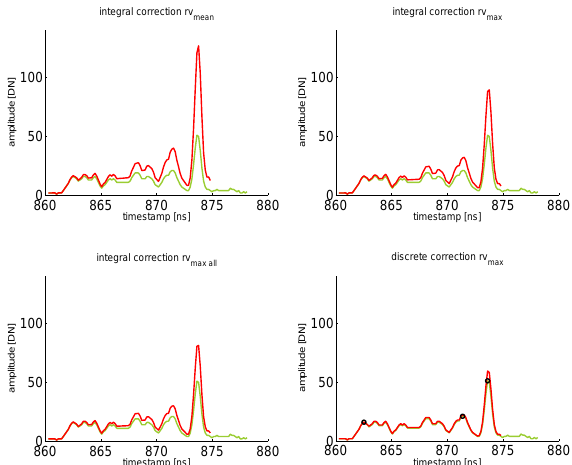
Figure 8: Comparison of raw data and corrected data with dif- ferent correction methods and reference values (rv mean /rv max = mean/maximum value of the areas under all eligible waveforms, rv maxall = highest occurring integral considering all waveforms), green: attenuated waveform, red: corrected waveform, black: de- tected